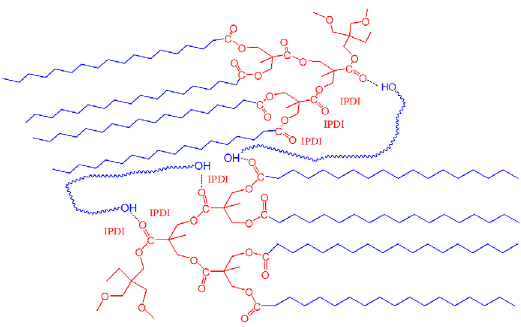
Figure 7. Conversion-time curves of the H-IPNs systems with 20 wt % H at different temperatures. 41